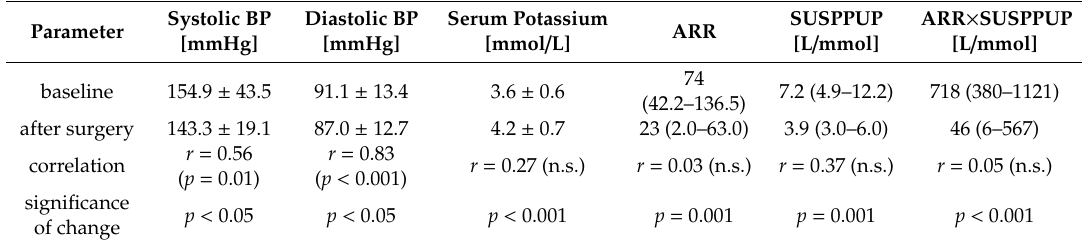
Table 5. Pairwise analysis of parameters of baseline and post-interventional